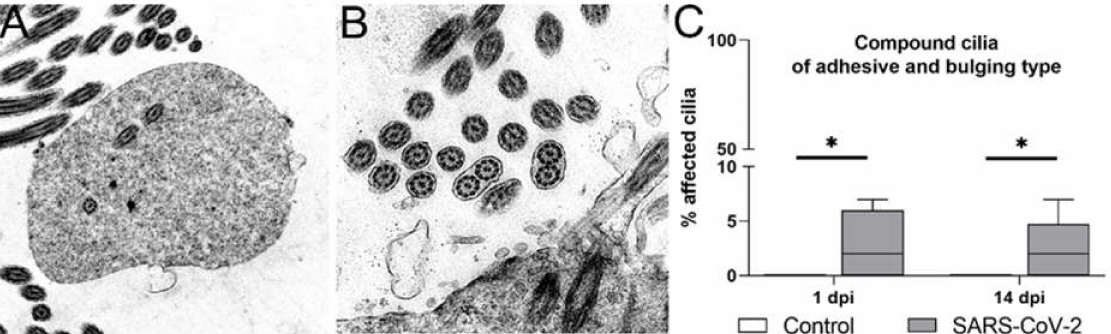
Figure 5. Ultrastructural abnormalities of cilia from SARS-CoV-2-infected hamsters in the tracheal epithelium before and after ciliary regeneration. ( A , B ) Examples of ciliary alterations observed by transmission electron microscopy of tracheal samples. The most common ultrastructural changes included compound cilia of the bulging type ( A ) and adhesive type ( B ). Magnifications are 16,000 × in ( A ), 20,000 × in ( B ). ( C ) The quantification of compound cilia of both types showed a significant increase in SARS-CoV-2-infected animals at 1 and 14 days post-infection (dpi). Box and whisker plots show medians, quartiles, and ranges. Asterisks indicate significant differences: * p < 0.05;